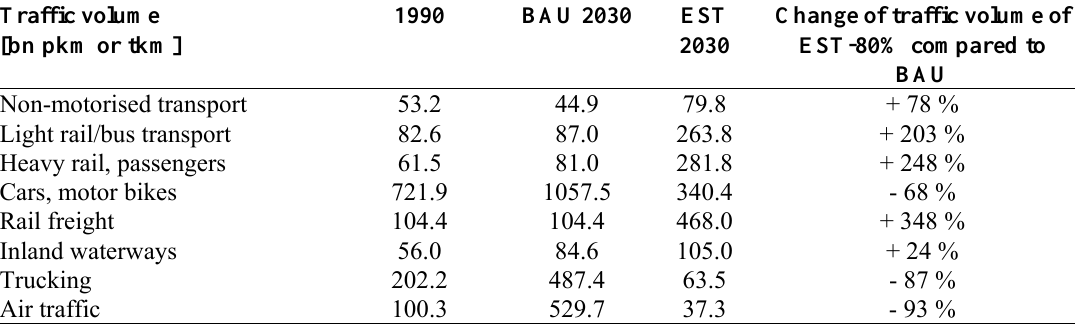
Table 2. Traffic Indicators of